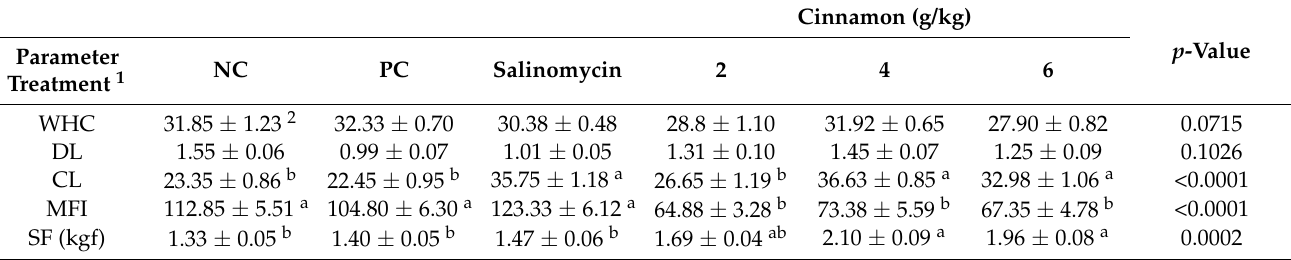
Table 5. Water-holding capacity (WHC), dripping loss (DL), cooking loss (CL), myofibril fragmenta- tion index (MFI), and shear force (SF) in broilers fed diets containing varying amounts of cinnamon bark powder